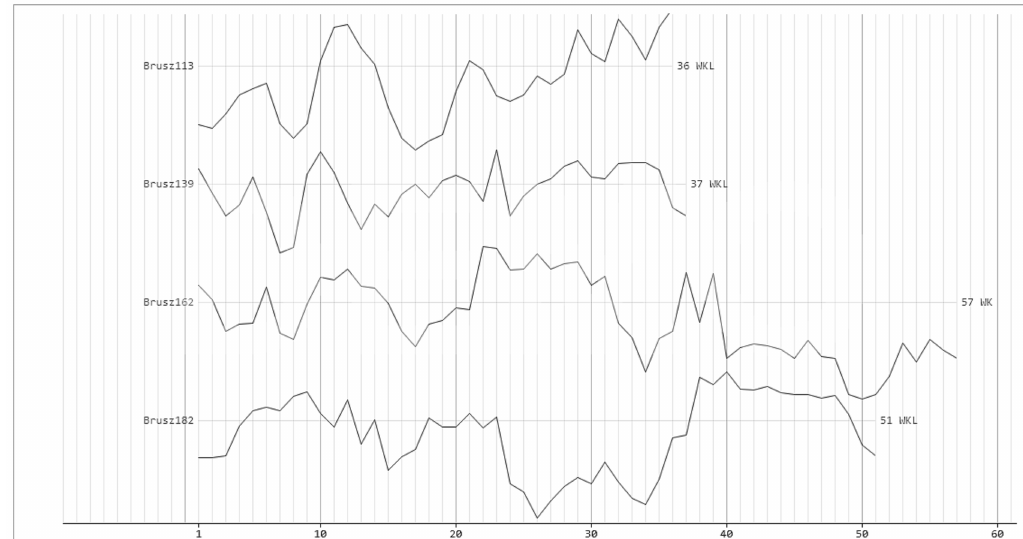
Figure 7. Examples of growth-ring sequences from shredded